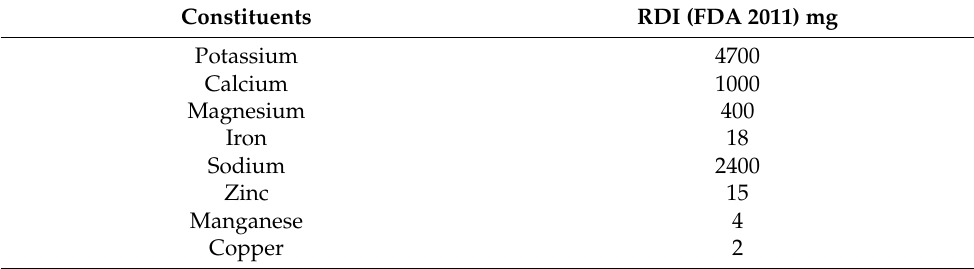
Table 5. The daily values of nutrients recommended per day (RDI) [60]. Constituents